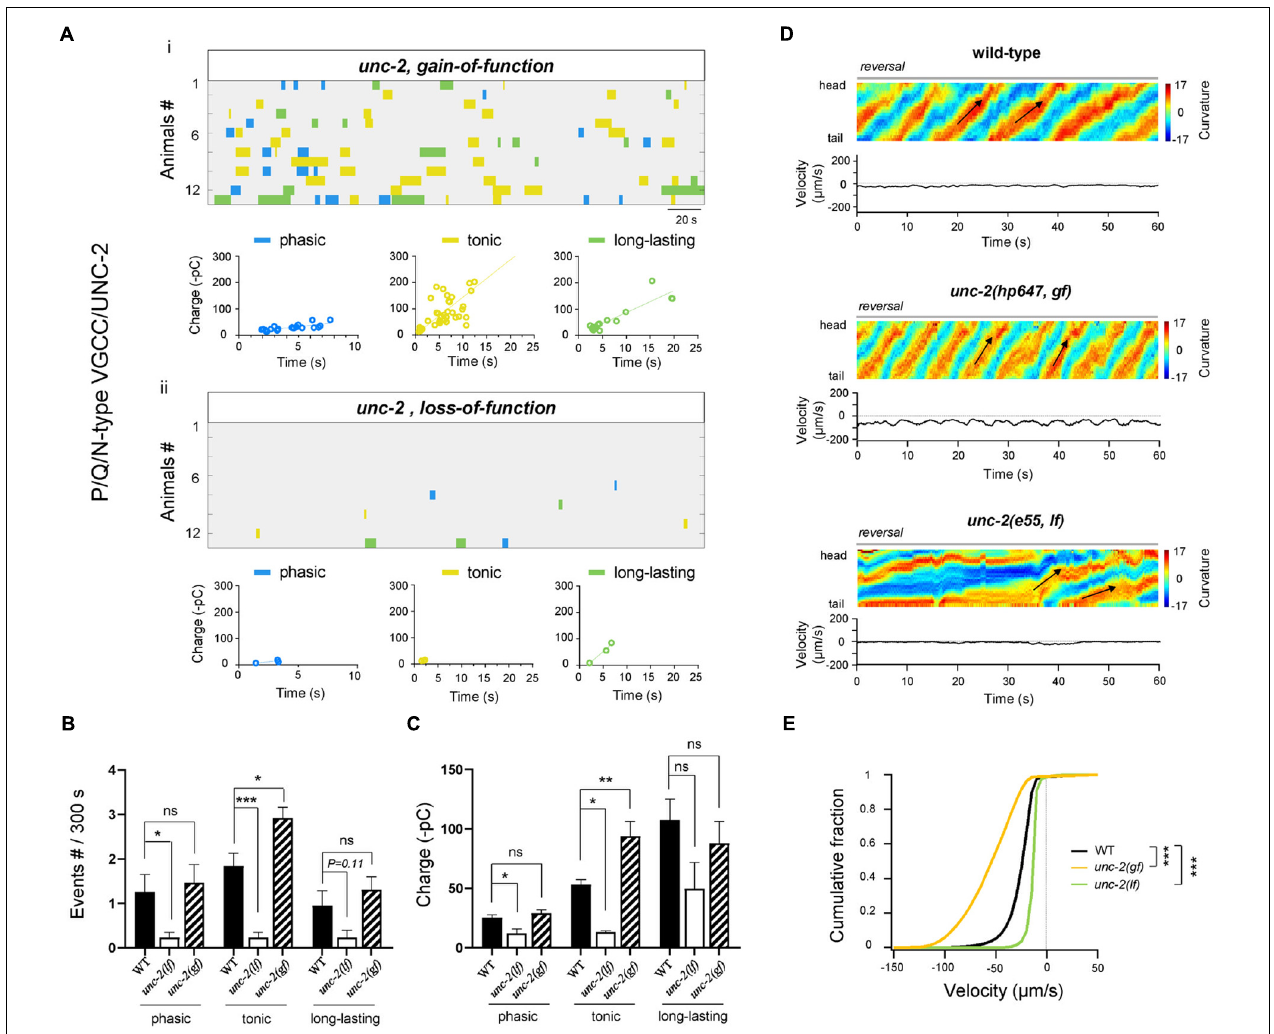
FIGURE 3 | High-voltage P/Q/N-VGCC(UNC-2) facilitates tonic and phasic rPSCs. (A) Colormap and charge efficiency (linear fitting) of all rPSC events from unc-2(hp647; gf) ( up ) and unc-2(e55; lf) ( bottom ) mutant animals, after the coablation of premotor INs and B-MNs. Blue dots denote phasic-type events, yellow dots denote tonic-type events, and green dots denote long-lasting-type events. (B,C) Quantification of the frequency and charge of different rPSCs in respective genotypes. n = 13 animals in each group. (D) Representative curvature kymogram ( up ) and instantaneous velocity ( bottom ) of free-behaving animals of respective genotypes after the ablation. unc-2(hp647; gf) mutant animals exhibit persistent fast reversal, as posterior to anterior propagating body bends (arrows), while unc-2(e55; lf) mutants exhibit almost sluggish backward locomotion. (E) Distribution of instantaneous reversal velocity of wild-type, unc-2(hp647; gf) and unc-2(e55; lf) mutant animals. The velocity fraction is drastically left-shifted in unc-2(hp647; gf) , and right-shifted in unc-2(e55; lf) mutants, respectively. n ≥ 10 animals in each group. *** p < 0.001 against ablated wild-type by the Kolmogorov–Smirnov test. All data are expressed as means ± SEM. Student’s t -test was used (B,C) . Kolmogorov–Smirnov test was used (E) . Statistical significance is indicated as follows: ns, not significant, * p < 0.05, ** p < 0.01, *** p < 0.001 in comparison with that as